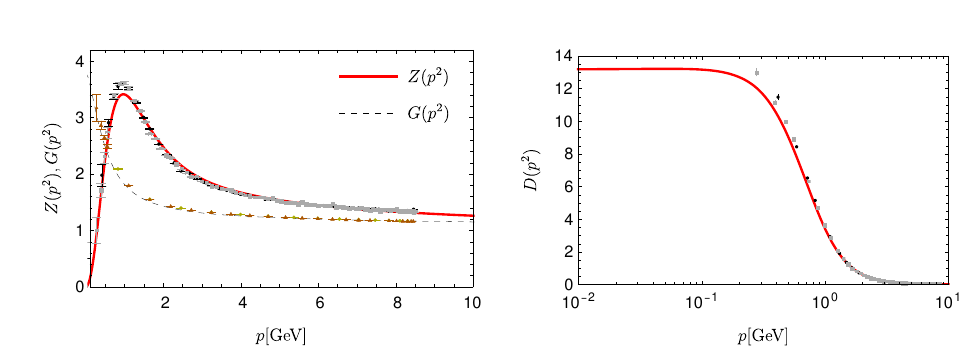
Figure 3. Gluon and ghost dressing functions Z ( p 2 ) and G ( p 2 ), respectively, (left) and gluon propagator D ( p 2 ) (right) [32] in comparison to lattice data